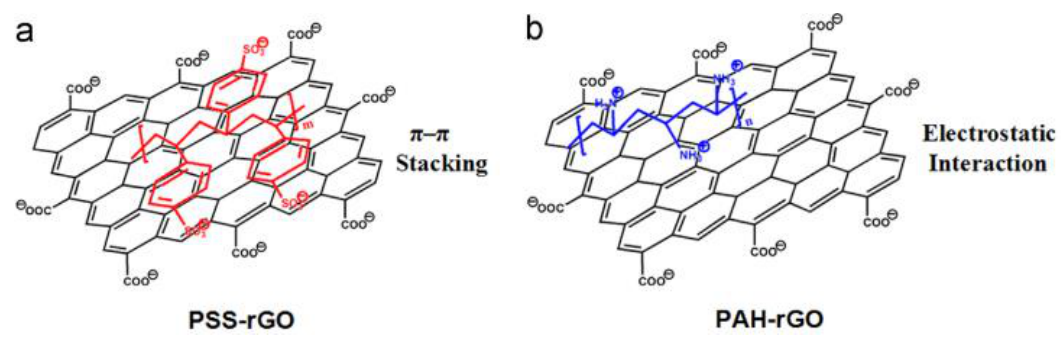
Figure 3. Schematic illustration of two composite materials: ( a ) PSS(−)rGO and ( b ) PAH(−)rGO. Reprinted from [57], with permission from the Elsevier.